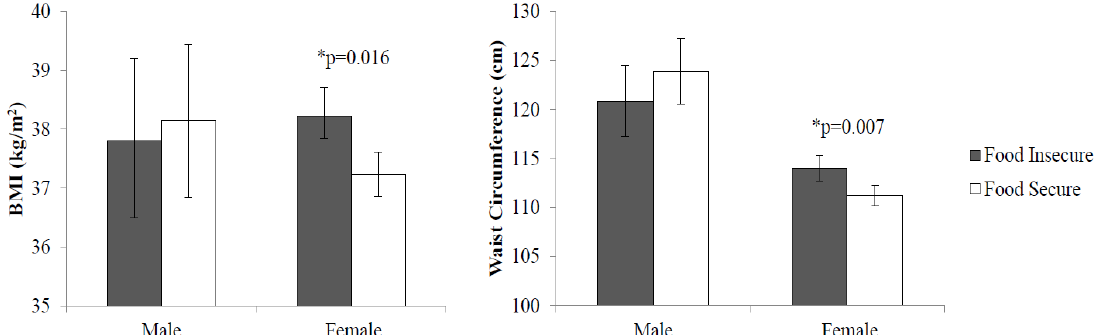
Figure 1. Adjusted Mean Adiposity by Food Security Status and Sex in PROPEL Patients. * indicates statistical significance ( p < 0.05). BMI, body mass index.